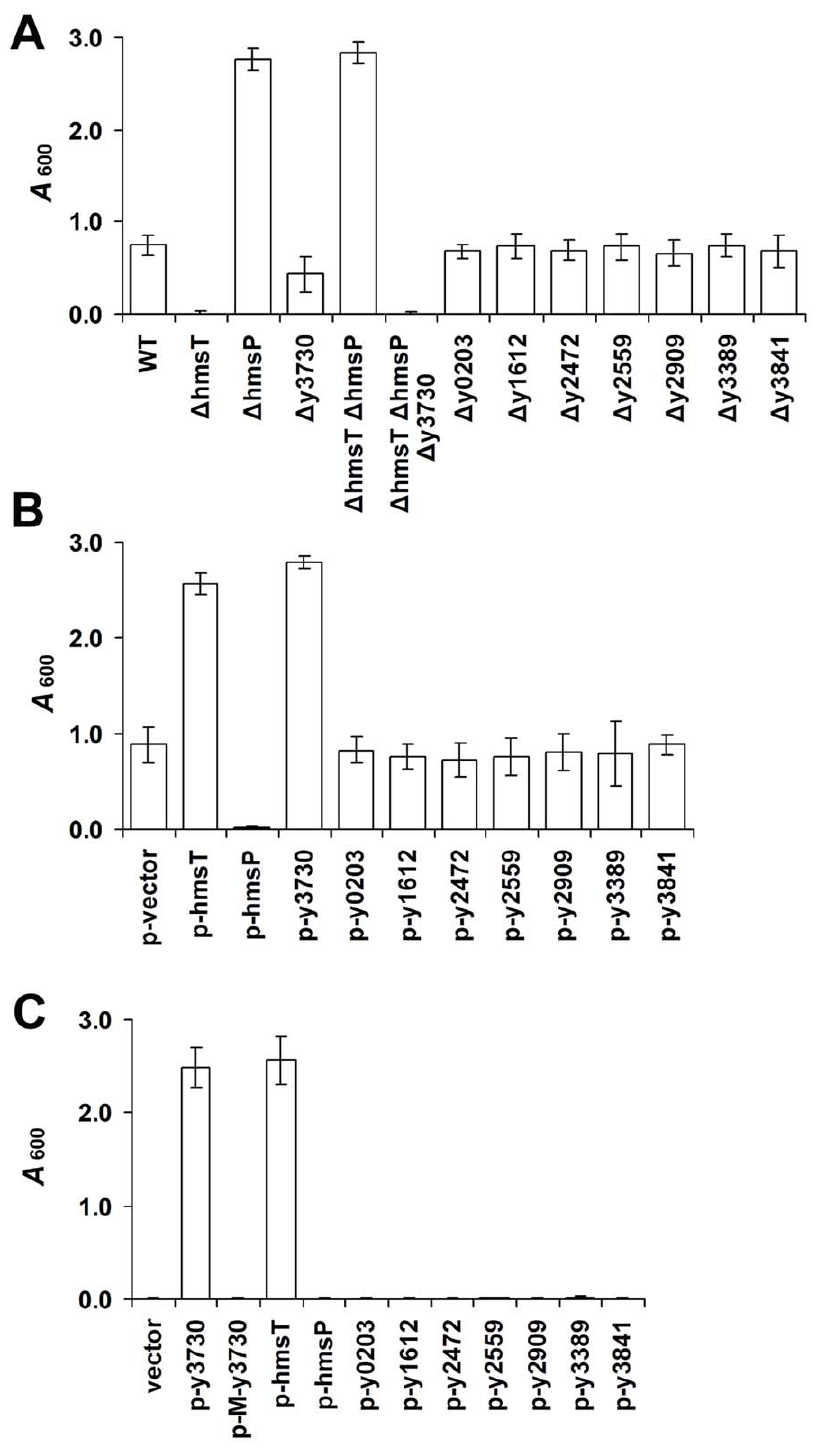
Figure 2. Effect of Y.pestis GGDEF-, EAL-, and HD-GYP-domain genes on invitro biofilm formation. A, B. Relative amounts of adherent biofilm made by Y. pestis KIM6 + parent strain and isogenic derivatives deleted of (A) or overexpressing (B) one of the genes listed in Table 1. C. Quantitation of biofilm made by the hmsT hmsP y3730 triple mutant strain overexpressing one of the genes listed in Table 1, or the mutated y3730 GGAAF allele. The mean and standard deviation of two or more independent experiments are indicated.